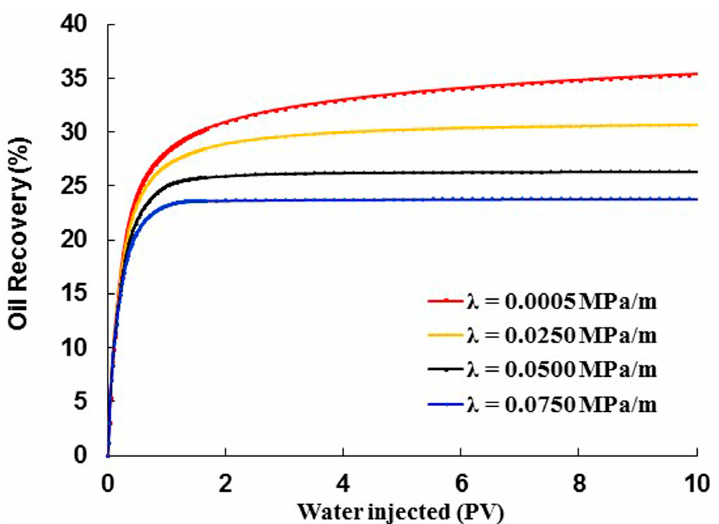
Figure 18. Oil recovery at different TPGs by the designed simulator.